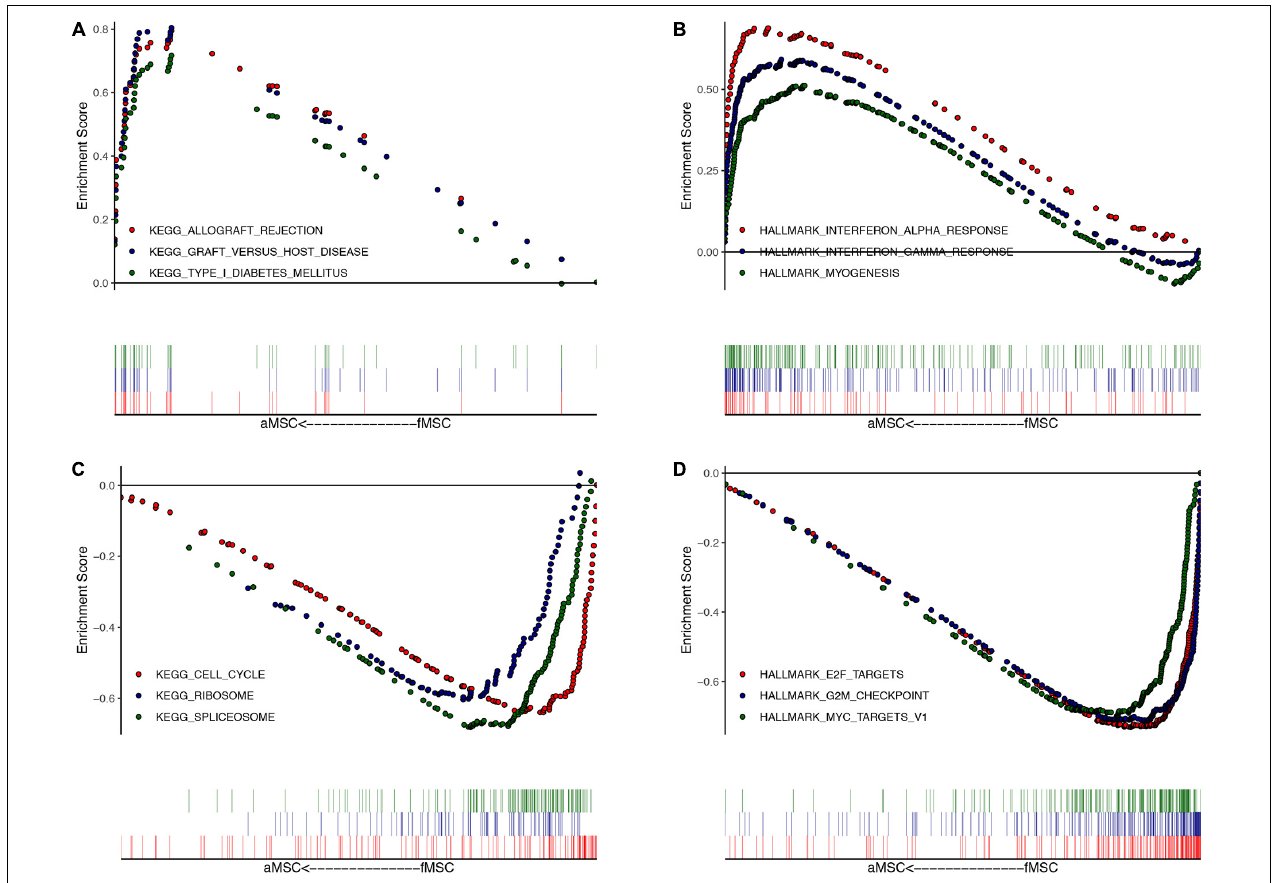
FIGURE 2 | Gene set enrichment analysis (GSEA) for DEGs. The top three enriched gene sets (according to GSEA enrichment score) in aMSC group: (A) for KEGG; (B) for HALLMARK. The top three enriched gene sets (according to GSEA enrichment score) in fMSC group: (C) for KEGG; (D) for HALLMARK. All gene sets are significantly enriched at a false discovery rate (FDR) < 0.05. The location of the vertical bar shows the occurrence of the gene in the ranked